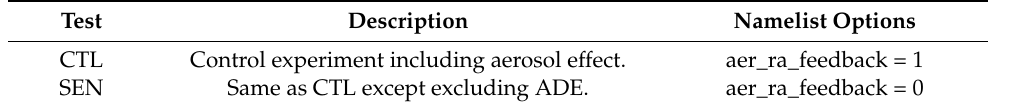
Table 2. Experimental design.